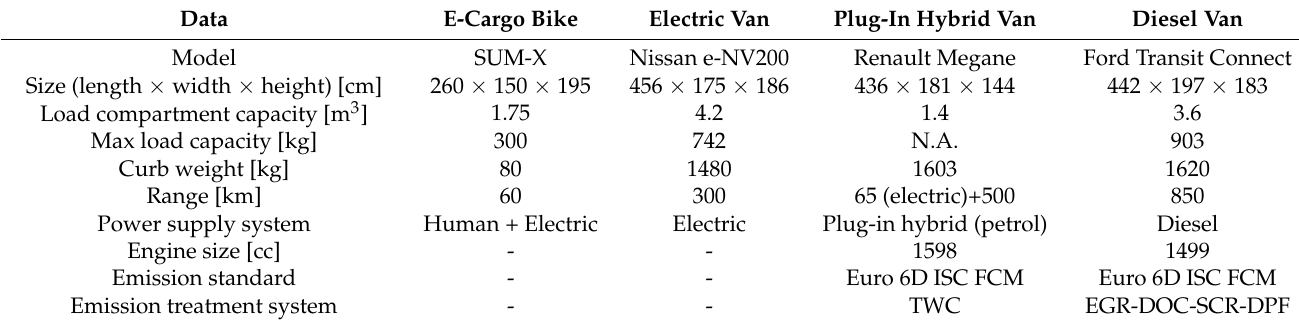
Table 1. Main features of the assessed